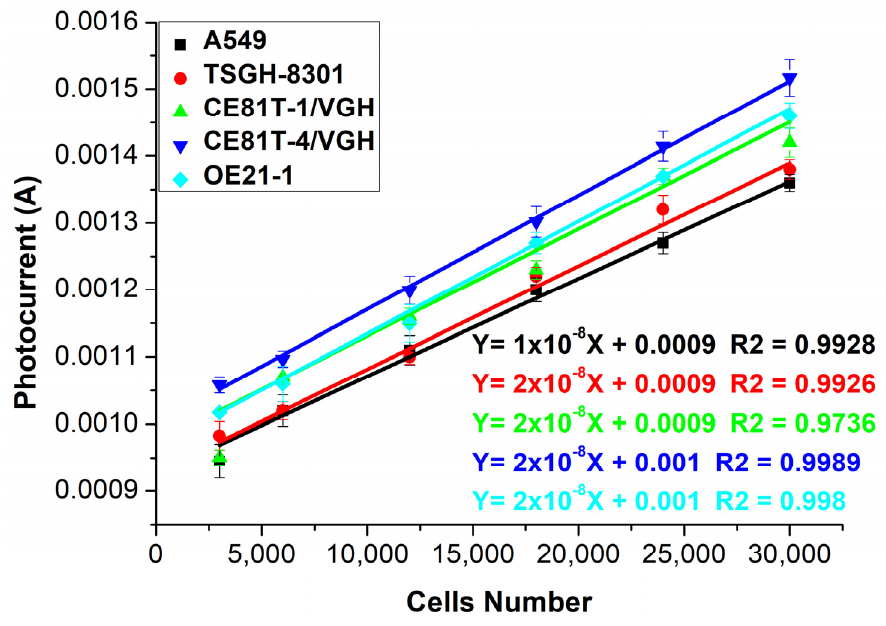
Figure 4. Photocurrent response measurement results of four cancer cells in tests using varying number of cells. Error bars represent the standard deviation of the measurement ( n = 5).